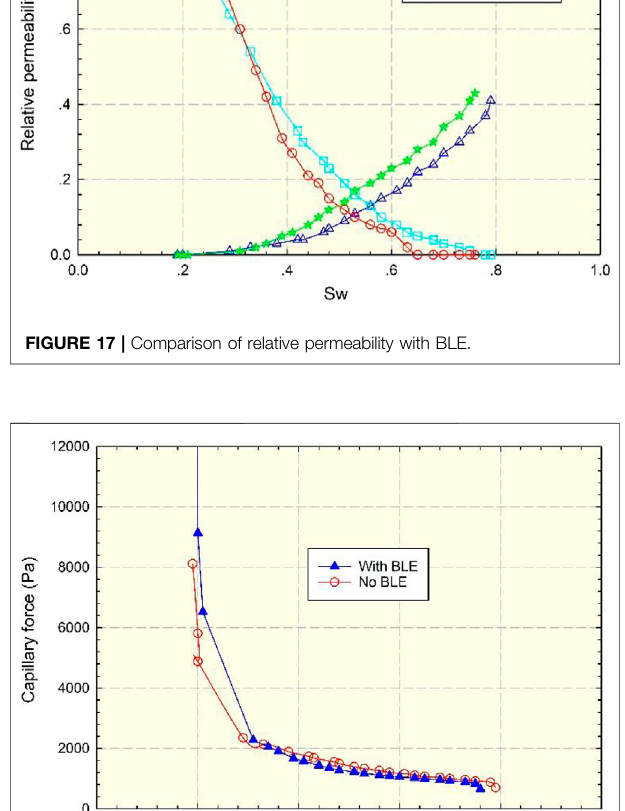
Frontiers in Earth Science |